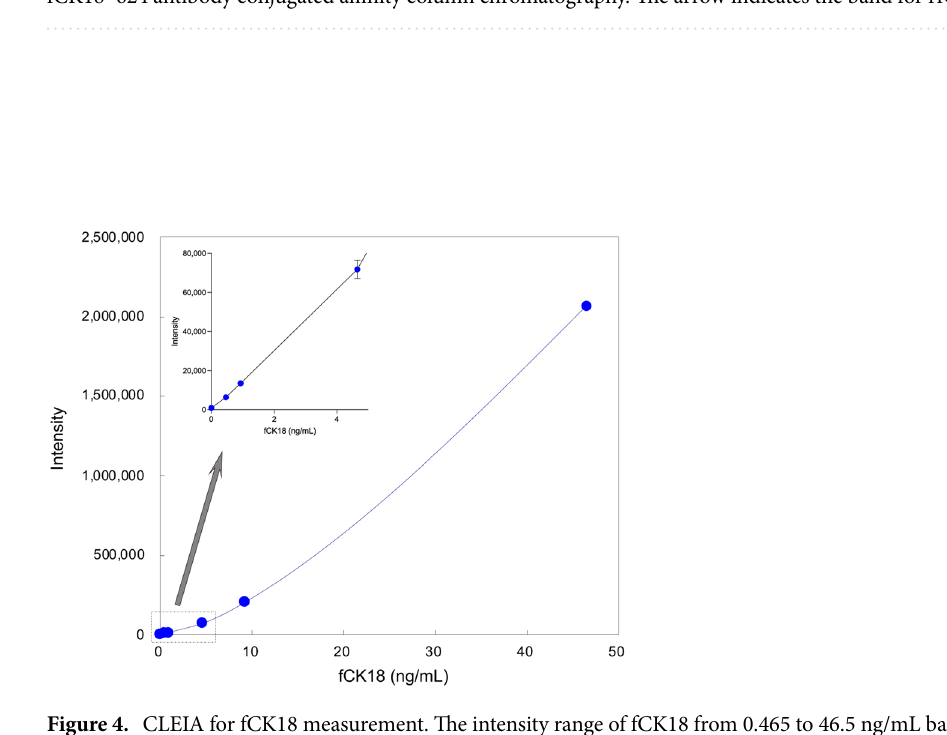
Figure 3. The expression of recombinant fCK18 in E. coli. ( A ) The immunoblot detection of recombinant fCK18 (rfCK18) proteins derived from 241 to 397 aa (left panel) and 261–397 aa (right panel) in E. coli culture supernatant (Sup) as a soluble protein and in the E. coli pellet (Pellet) as a inclusion body. The arrows indicate the band for rfCK18. ( B ) SDS-PAGE analysis of purified rfCK18 protein (261–397 aa) in the soluble fraction by fCK18–624 antibody conjugated affinity column chromatography. The arrow indicates the band for rfCK18.